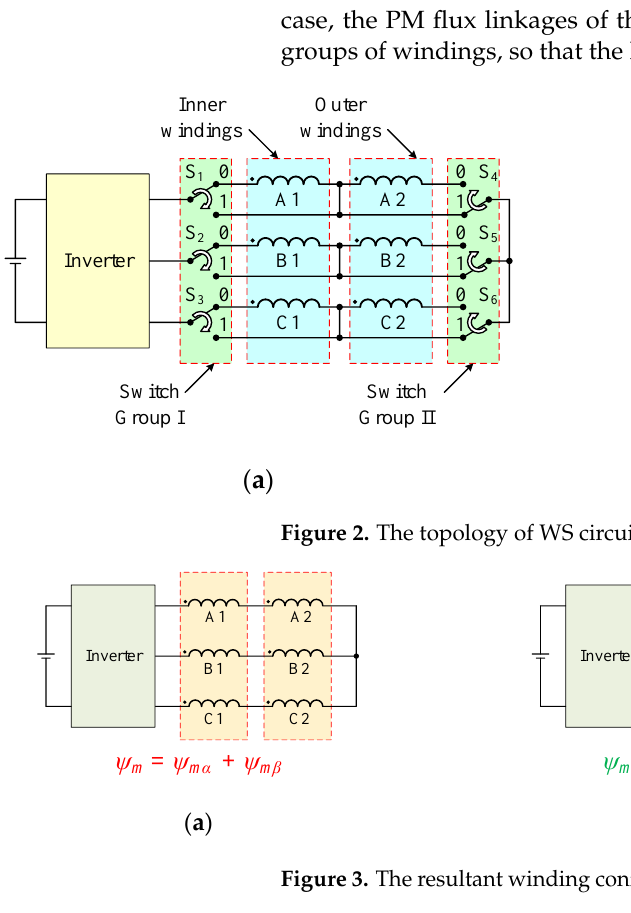
Figure 3. The resultant winding configurations of the WS circuit type I. ( a ) T1M1. ( b ) T1M2. ( c ) T1M3.